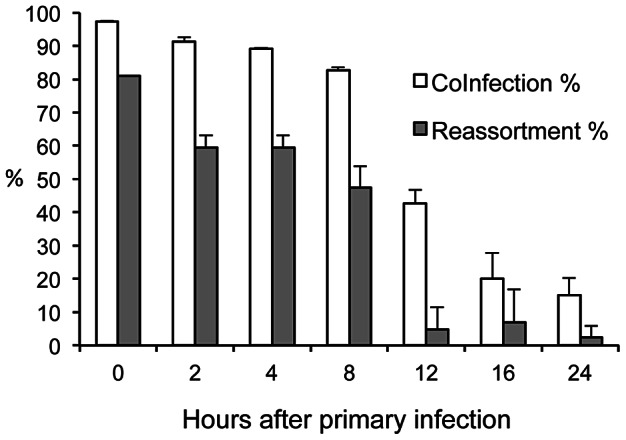
Super-infection delayed by up to 12 h allowed robust co-infection and by up to 8 h allowed robust reassortment in cell culture.MDCK cells were infected at MOI 10 PFU/cell with rPan/99var2-HA virus at 0 h and then super-infected at MOI 10 PFU/cell with rPan/99wt-HIS virus after the indicated time interval. Clonal isolates from supernatant collected 12 h after the wt virus infection were obtained and genotyped to determine the % reassortment. Flow cytometry was performed on the harvested cells to determine % co-infection. To prevent multiple cycles of replication, infections were performed in the absence of trypsin. Average values (n = 2 cell culture dishes) +/− standard deviations are shown.